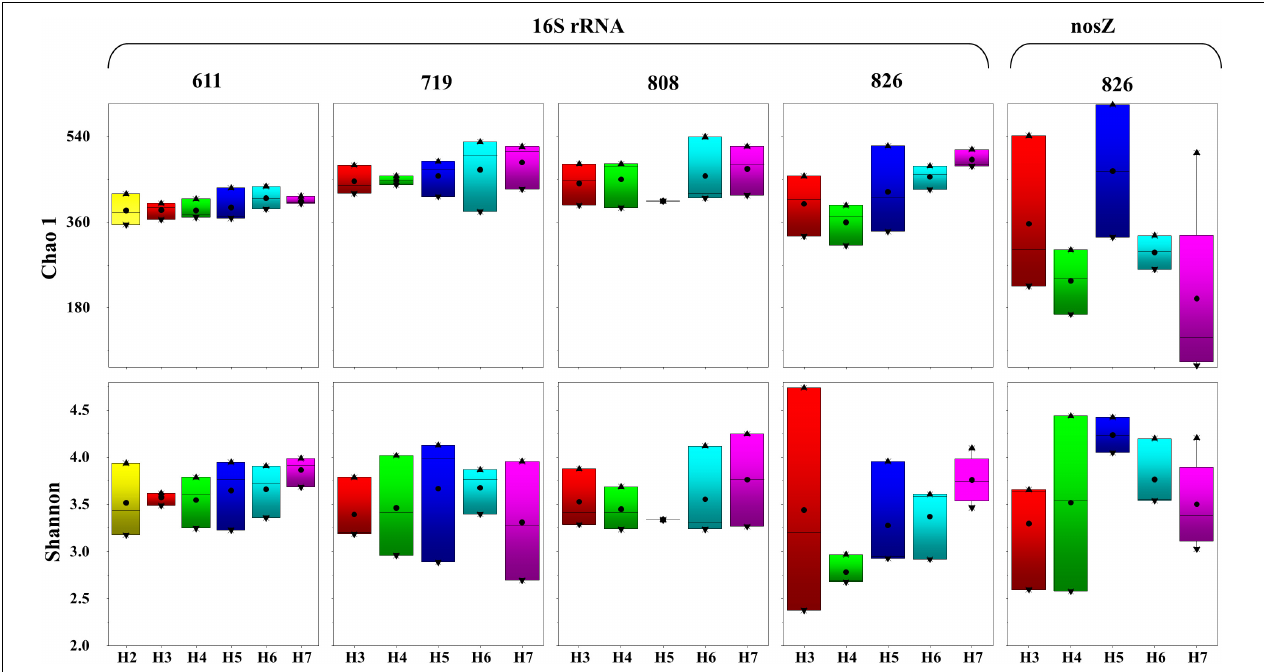
FIGURE 3 | Alpha diversity of 16S rRNA and nosZ gene-encoded bacteria at each sampling time. Thick bar represents median, black point represents average, boxes represent the middle 50% of the data, and whiskers represent the upper and lower quartiles.